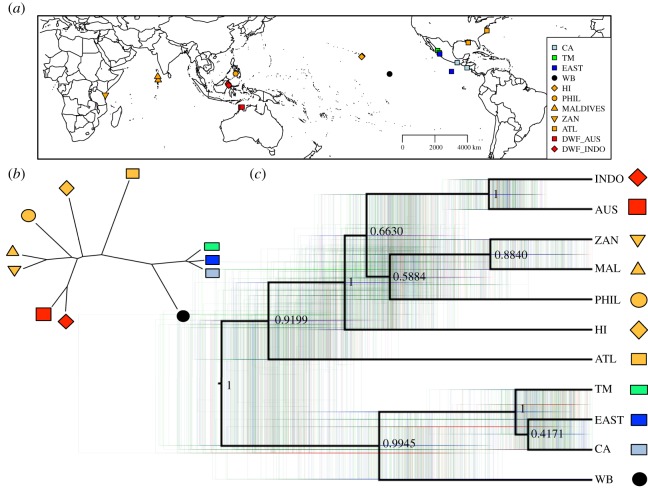
Bayesian species tree for spinner dolphins using 3340 SNPs. (a) A map representing the sampling localities for the reduced sample set used (n = 22) to decrease computation time for phylogeographic analysis (see electronic supplementary material, table S1). (b) The unrooted maximum clade credibility (MCC) tree. CA: Central America subspecies (S. l. centroamericana) is labelled with a light blue box. EAST: Eastern spinner dolphin subspecies (S. l. orientalis) is the dark blue box. WD: whitebelly spinner is the black circle. All other pantropical (S. l. longirostris) are labelled in orange: ATL = NW Atlantic; HI = Hawai‘i; ZAN = Tanzania (Zanzibar); PHIL = Philippines. Red populations are dwarf spinner dolphins from Indonesia (diamond = INDO) and northern Australia (square = AUS). (c) In black is the mid-point rooted MCC tree. The MCC tree is overlaid on all trees (coloured) from the analyses (blue trees are the most common, red are the next most common and green are the least common). Nodes are labelled with posterior probabilities.